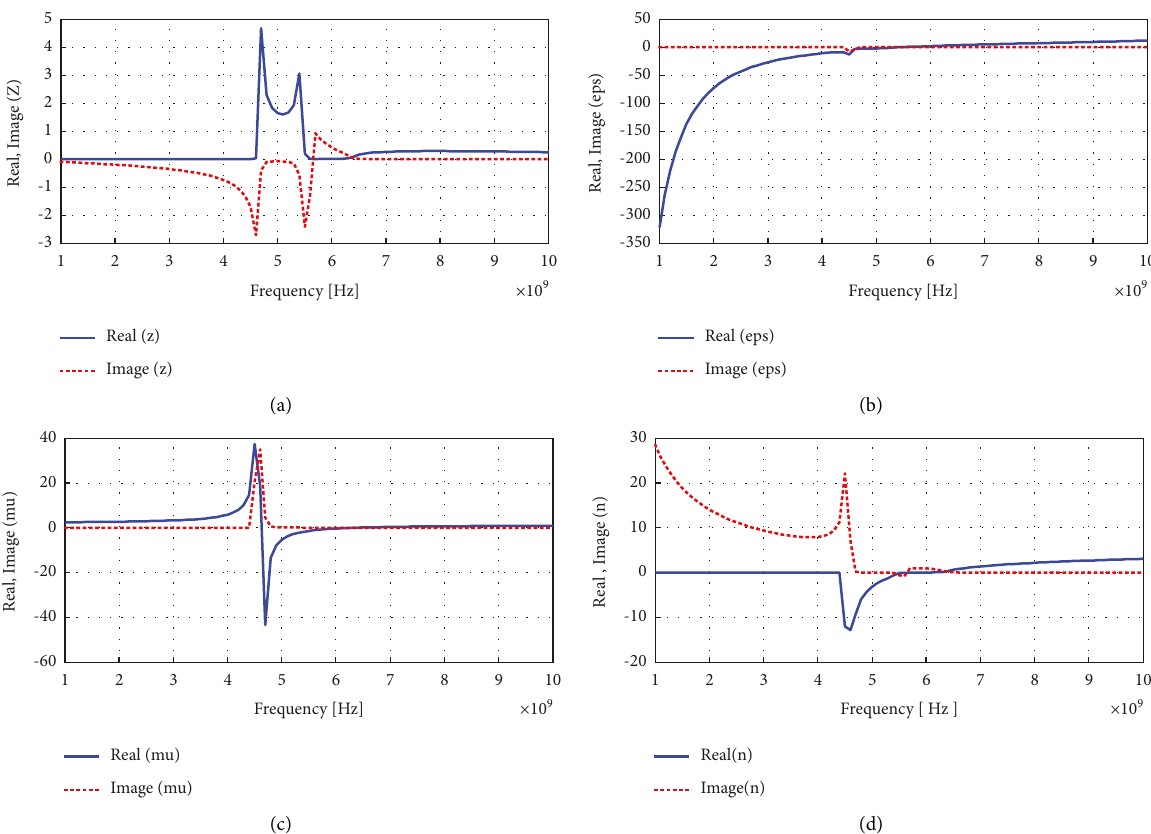
Figure 7: (a) The impedance, (b) electrical permittivity, (c) magnetic permeability, and (d) refractive index, of the proposed metamaterial structure.